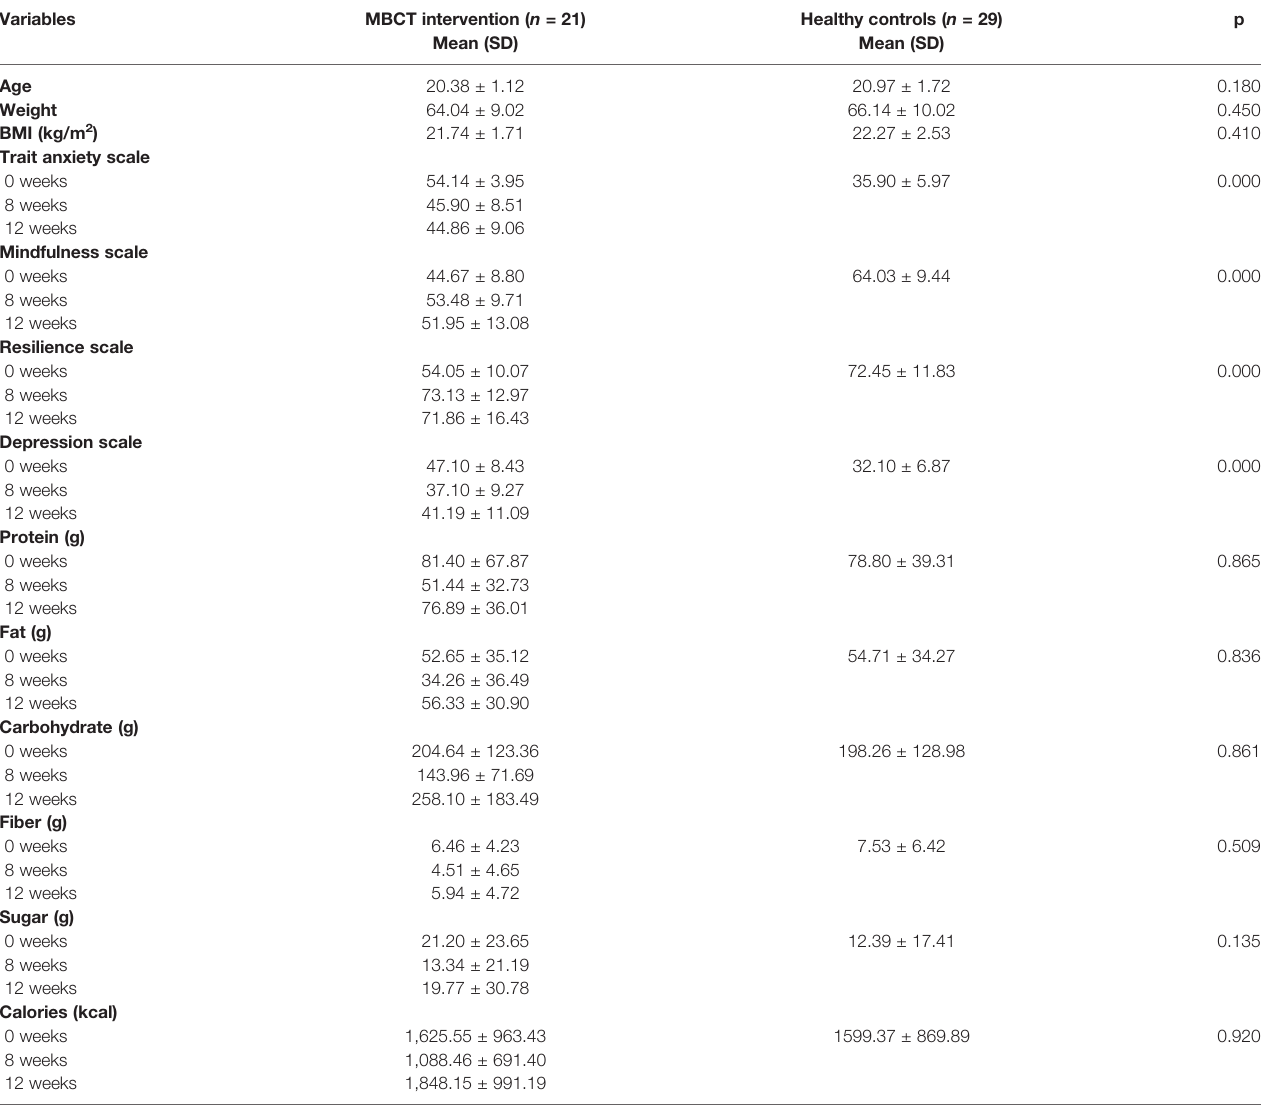
TABLE 1 | Demographics and information on mental health and daily nutrients at each time points.